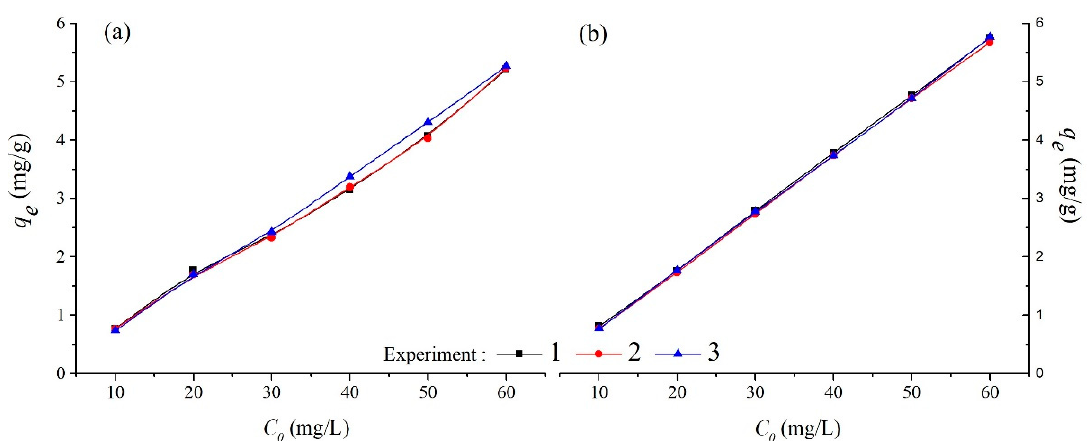
Figure 5. ( a ) Effect of the initial Basic Navy Blue 2RN (CNB)concentration on adsorption capacity. ( b ) Effect of the initial Drimaren Yellow Cl-2R (ADY) concentration on adsorption capacity. Adsorbent dose 0.5 g/50 mL. pH (cationic) = 6, pH (anionic) = 2. Table 4. Framework for the study of the dye concentration effect on the amount of adsorbate